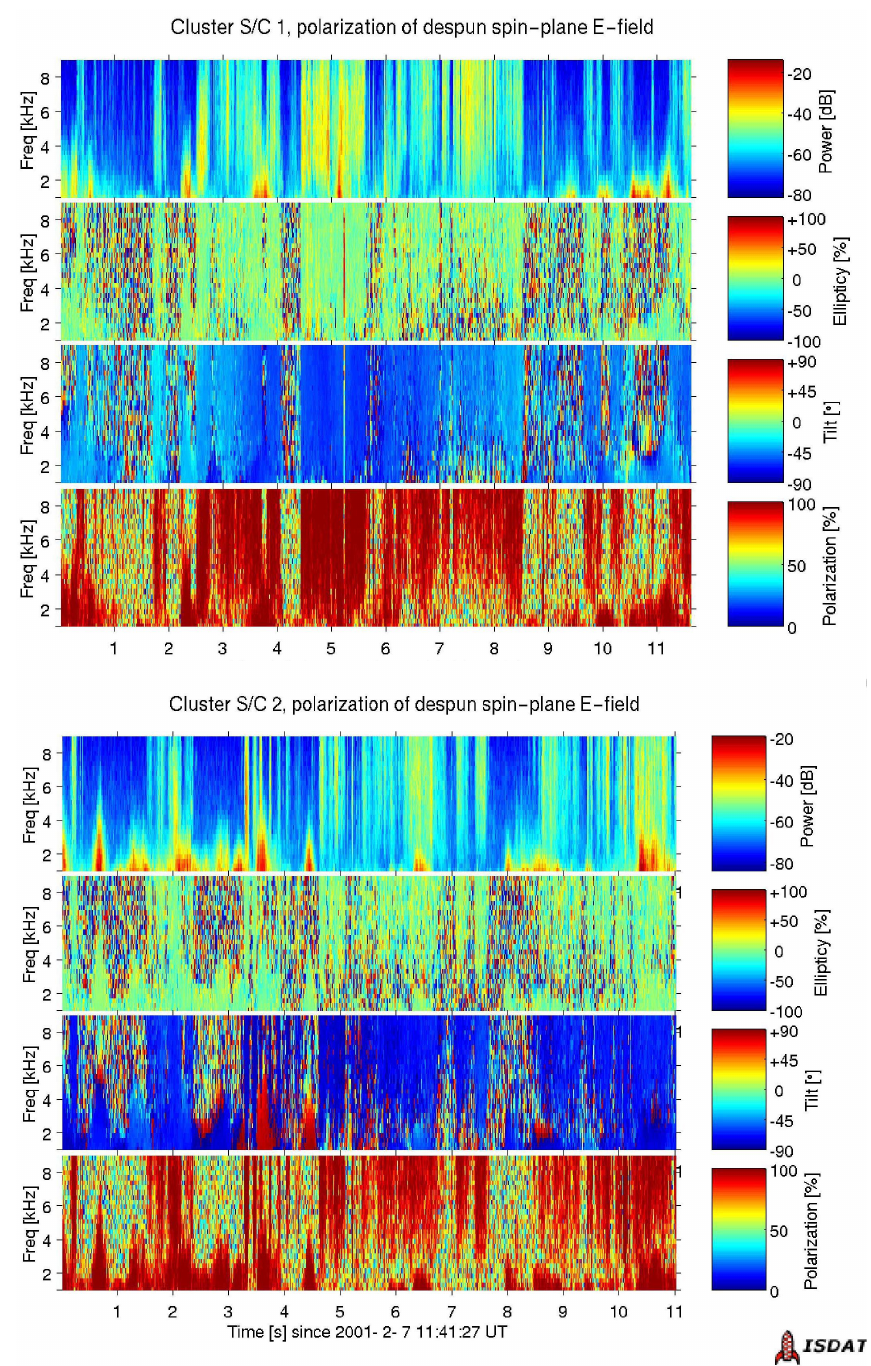
Fig. 4. Polarization plots of internal memory burst data. The panels of polarization are from top to bottom, respectively, the total power I , the degree of ellipticity v , the tilt angle φ , and the degree of polarization p